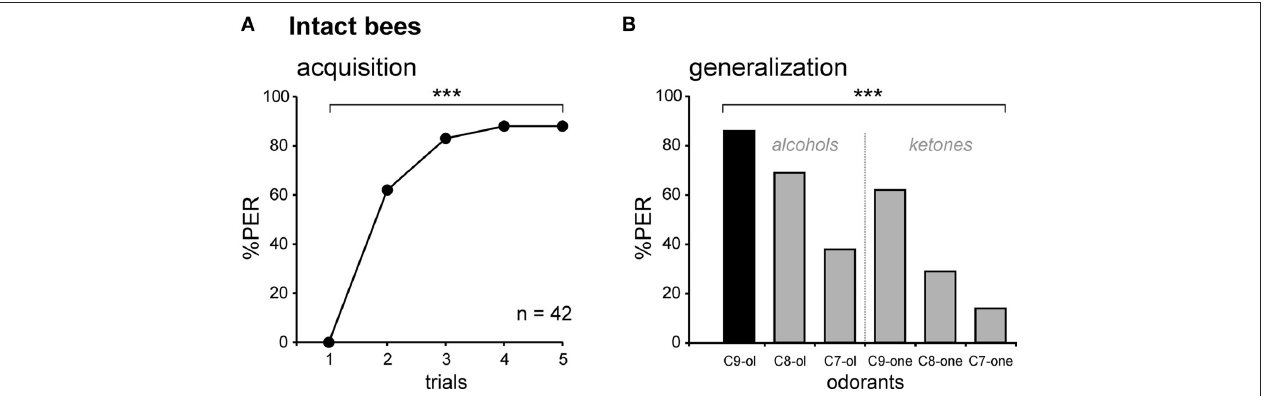
FIGURE 3 | Associative olfactory conditioning and generalization tests on intact honey bees. (A) Intact bees learn to associate the odorant CS (1-nonanol, C9-ol) with the sucrose US, as shown by the increase in the PER percentage along trials ( n = 42 ; *** p < 0.001 , Cochran’s Q test). (B) Generalization tests after PER conditioning, using 5 new odorants which differed from the CS by their chain length (C8-ol and C7-ol), by their functional group (C9-one) or both (C8-one, C7-one). Intact bees respond differentially to the tested odorants ( *** p < 0.001 , Cochran’s Q test), depending on their chemical properties, and show no extinction. Abbreviations: C8-ol, 1-octanol; C7-ol, 1-heptanol; C9-one, 2-nonanone; C8-one, 2-octanone; C7-one, 2-heptanone.